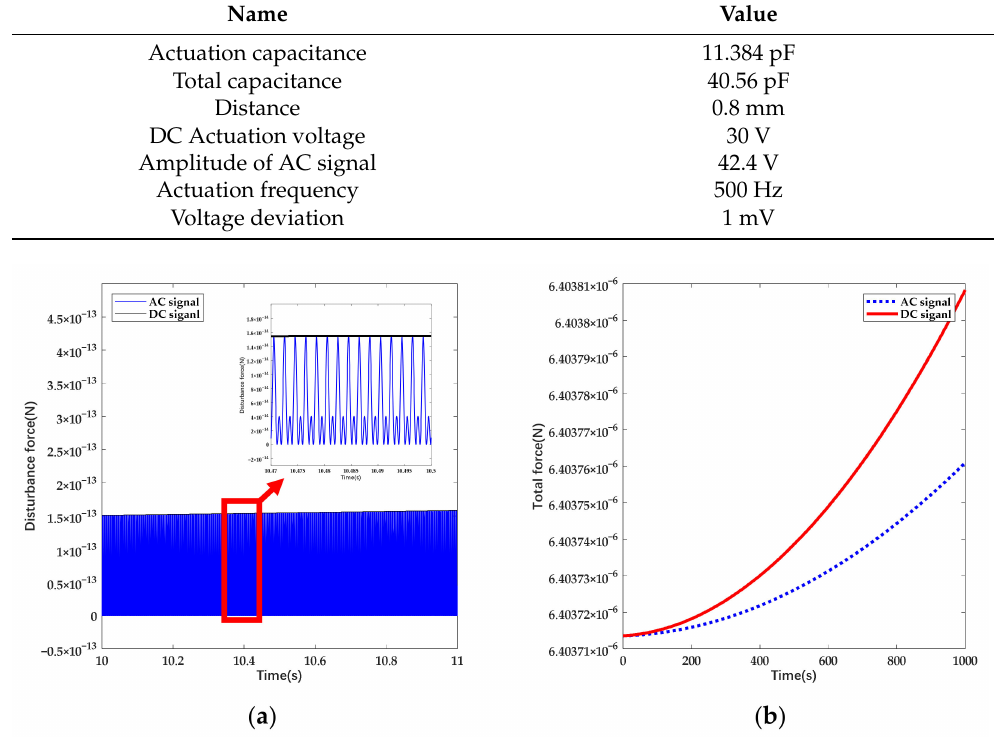
Figure 4. The variation of disturbance force and total force with linearly increasing deposited charge in time domain: ( a ) Original calculation result of disturbance force; ( b ) Total electrostatic force; the force under AC actuation is attained as effective